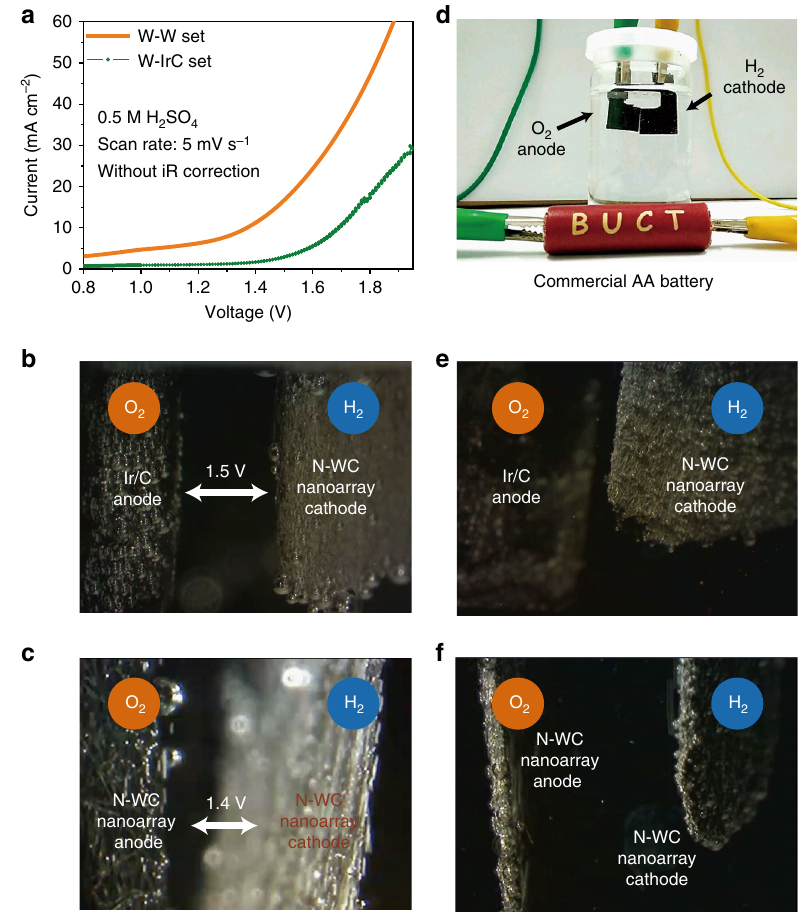
Fig. 7 Overall water splitting. a The Volt-ampere curves of overall water splitting with N-WC nanoarray as the cathode, while using Ir/C (noted as W – IrC set) or N-WC nanoarray (noted as W – W set) as the anode. b The video snapshot of water electrolysis by W – IrC set with voltage at 1.5 V. c The video snapshot of water electrolysis by W – W set with voltage at 1.4 V. d Setup for overall water splitting powered by a commercial AA battery, and the corresponding snapshots of gas bubbling with water electrolysis of W – IrC set ( e ) or W – W set ( f